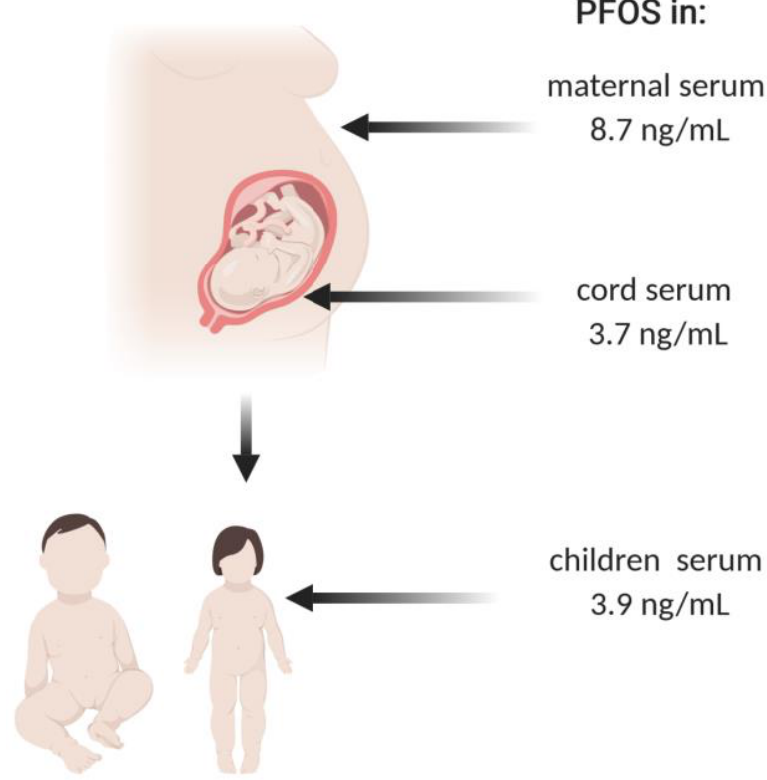
Figure 5. Concentrations of PFOS (mean) in maternal, cord and children serum [136,193]. The blood–placenta barrier limits the penetration of PFASs to the fetus. In the first years of life, the concentration of PFASs in the serum starts to increase.